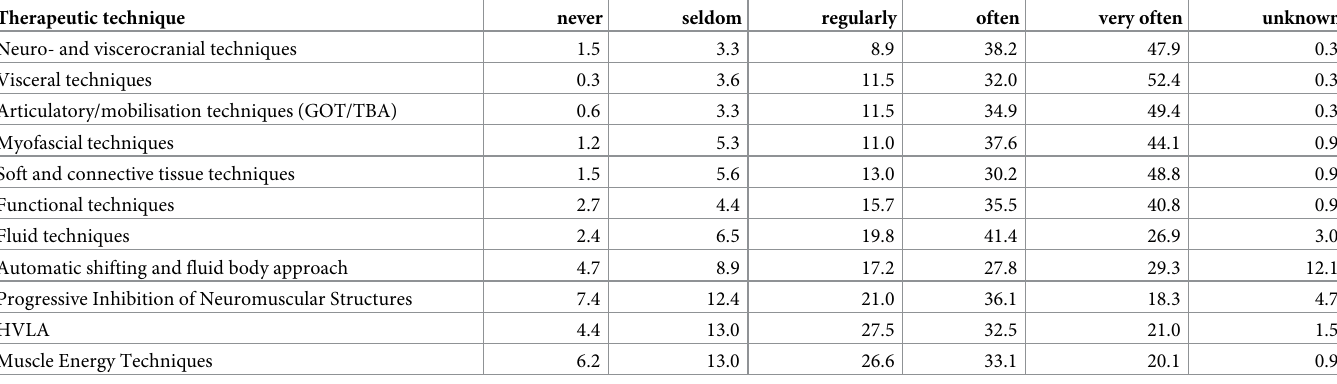
Table 6. The most common therapeutic techniques used (in descending order of ‘often’ and ‘very often’